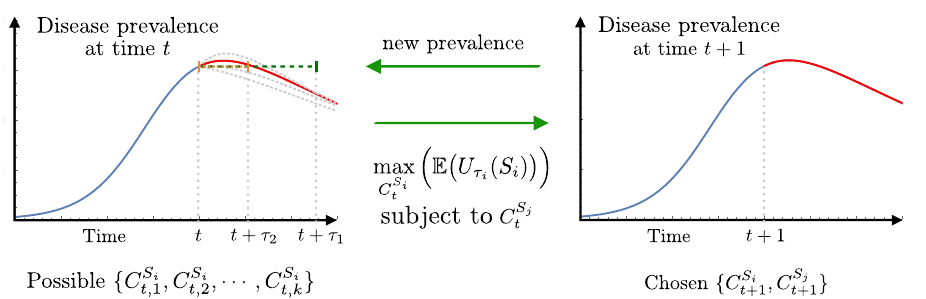
Figure 2. Coupling disease dynamics and forward looking Markov Decision Processes. At each time step the sequential decision process sets a feedback loop between the epidemic state and individual behavioral responses: ( i ) the current disease prevalence defines potential future health state transitions, ( ii ) a projection of the system’s future state over the planning horizon sets the optimization problem, ( iii ) we find the population-specific optimal contact rates that maximize the expected utility of the susceptible population, over the planning horizon and simulate the epidemic model one step